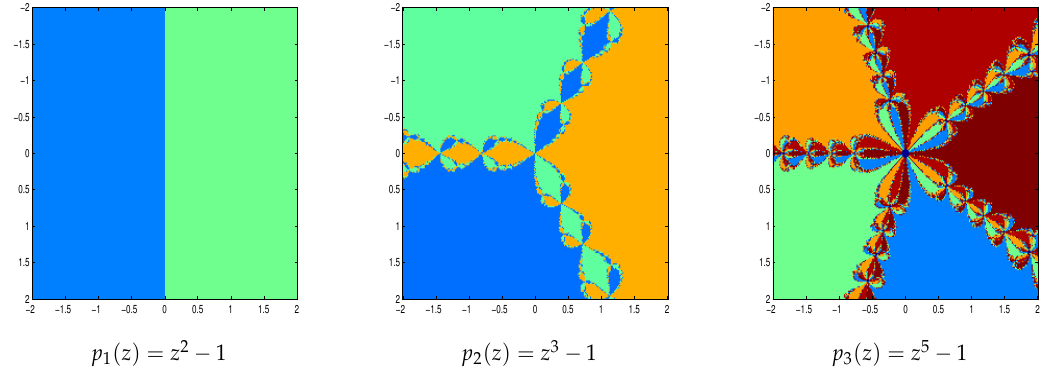
Figure 2. Basins of attraction for 2 nd NR for the polynomial p 1 ( z ) , p 2 ( z ) , p 3 ( z )